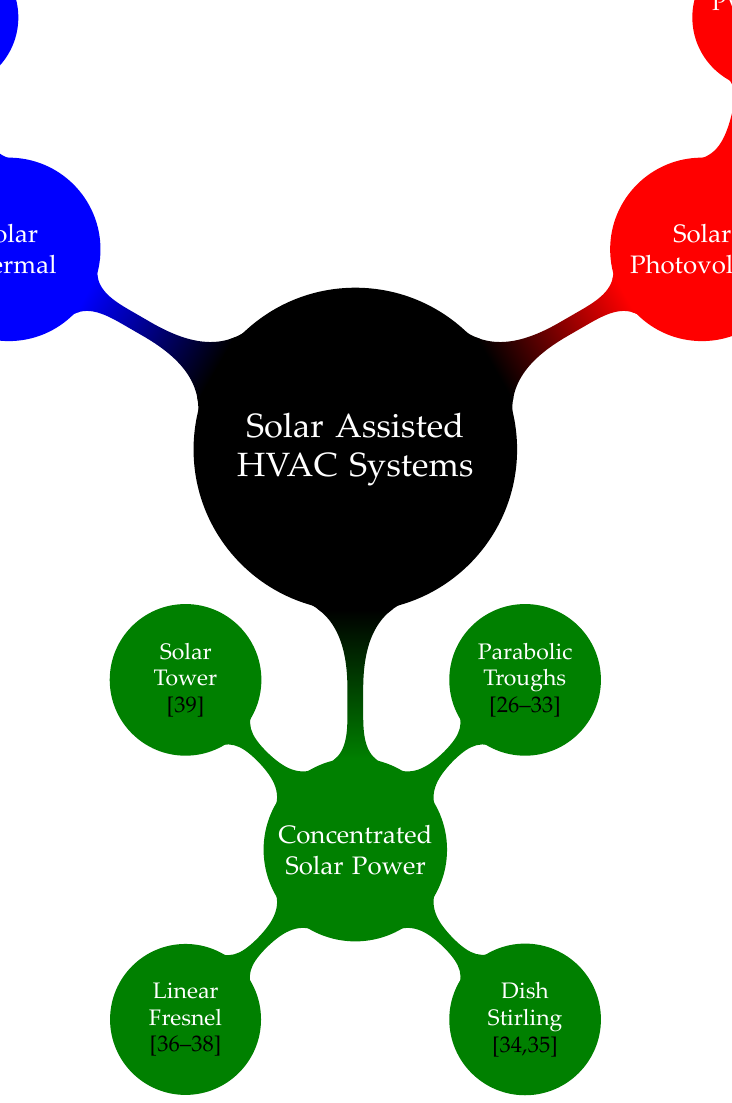
Figure 1. Types of solar-assisted HVAC systems for buildings